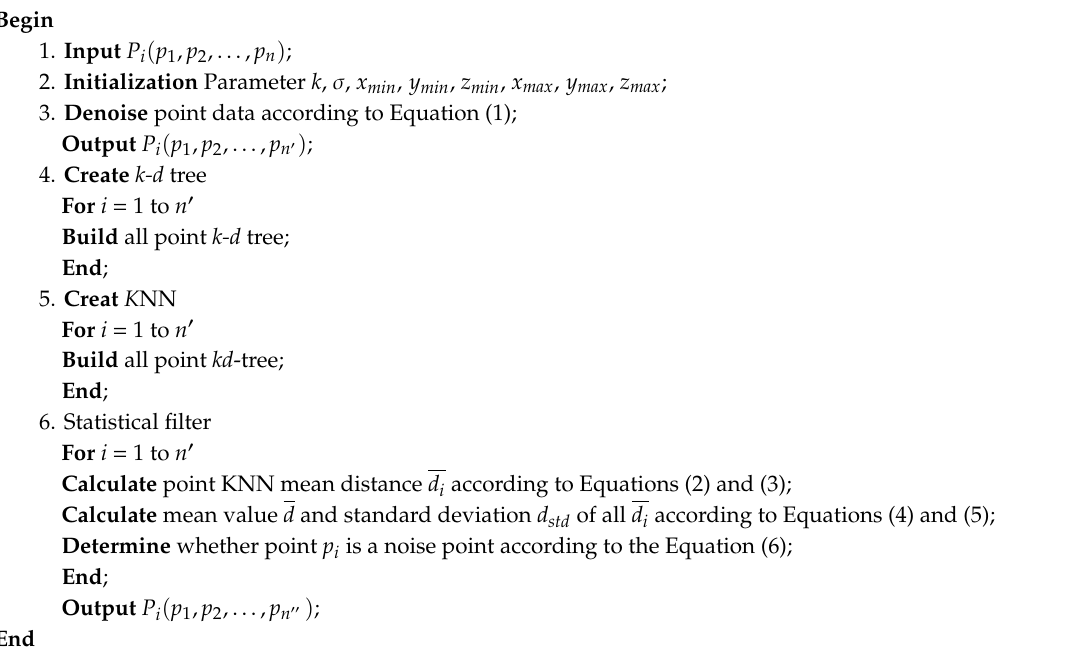
Algorithm 1 Pseudocode of hybrid denoising algorithm